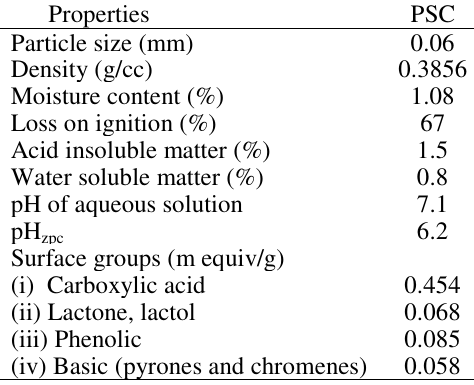
Table 1 Characteristics of the adsorbent